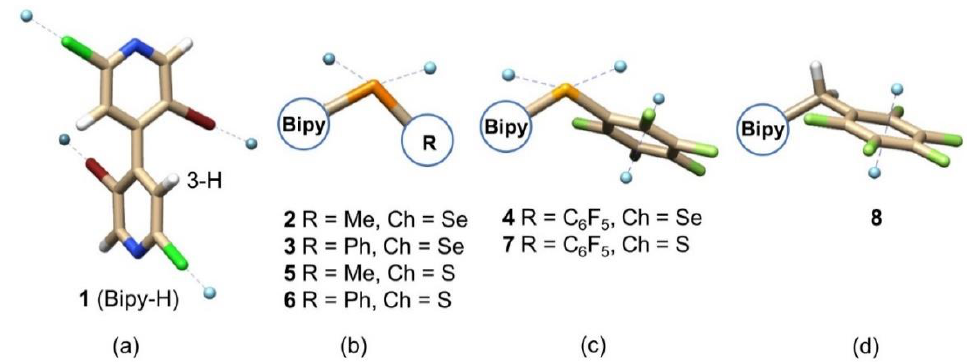
Figure 3. σ- ( a – c ) and π-hole ( c , d ) patterns in compounds 1 – 8 . Tube structure colors: bromine Figure 3. σ - ( a – c ) and π -hole ( c , d ) patterns in compounds 1 – 8 . Tube structure colors: bromine (red), chlorine (green), (red), chlorine (green), fluorine (clear green), hydrogen (white), nitrogen (blue), chalcogen (S, Se) fluorine (clear green), hydrogen (white), nitrogen (blue), chalcogen (S, Se) (orange), σ -/ π -hole (pale (orange), σ-/π-hole (pale blue).